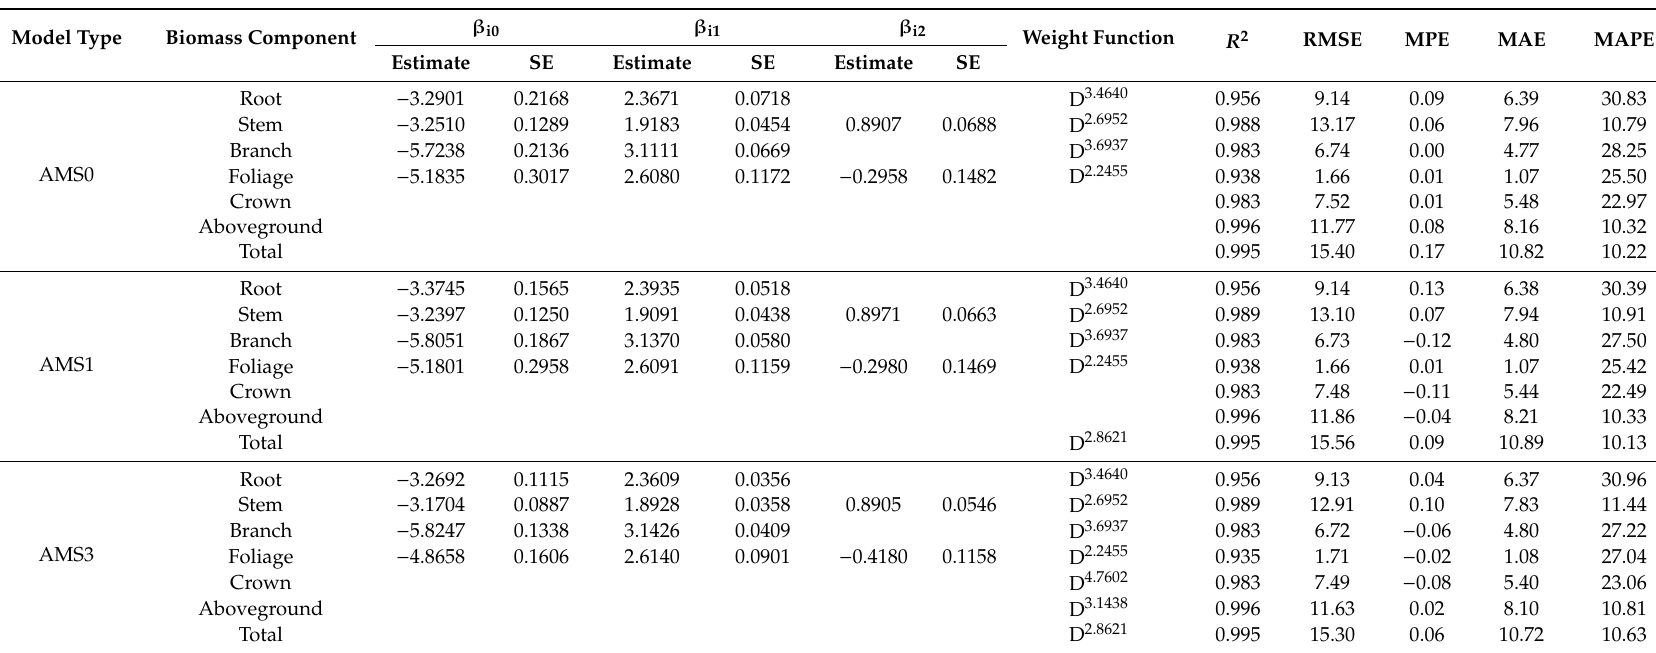
Table 5. Parameter estimates, standard errors (SE), model fitting statistics, weighting functions, and jackknifing validation for AMS0, AMS1, and AMS3 based on a combination of D and